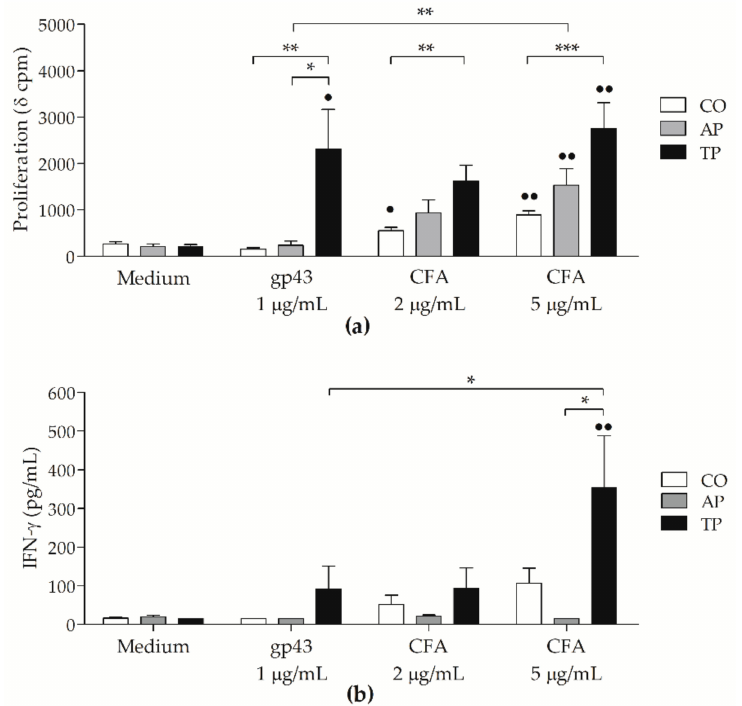
Figure 4. Induction of lymphoproliferation by P. brasiliensis antigens on peripheral blood mononu- clear cells (PBMCs) culture: ( a ) proliferation of PBMCs was measured by [ 3 H]-thymidine uptake on cells; ( b ) levels of IFN- γ (pg/mL) determined on culture supernatants from non-PCM control subjects (CO: white bars; n = 17), and patients with active PCM (AP: grey bars; n = 08) or treated PCM (TP: black bars; n = 12), after 120 (proliferation) or 144 h (IFN- γ ) of stimulation with gp43 (1 µ g/mL) or CFA (2 or 5 µ g/mL), or left untreated (Medium). Results expressed as means with SEM of δ cpm, and capped lines indicate statistically significant differences with respective p values * p < 0.05, ** p < 0.01 or *** p < 0.001; black dots above the bars indicate differences in comparison with Medium: • p < 0.05 or •• p <